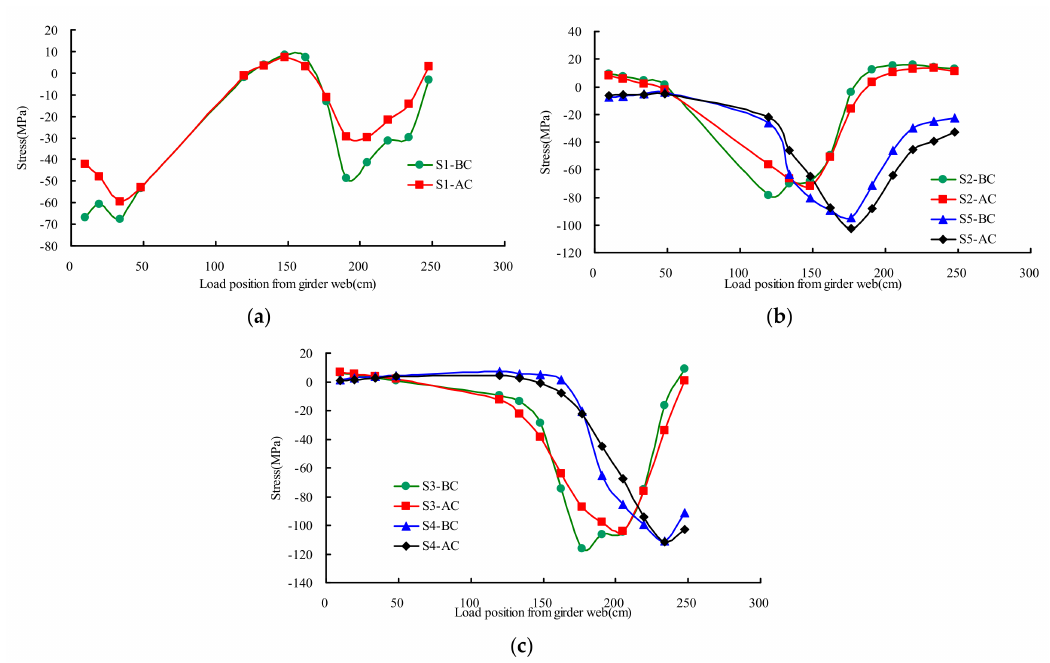
Figure 10. Mean stresses of diaphragm cutout under transverse wheel positions: ( a ) S1; ( b ) S2 and S5; ( c ) S3 and S4.